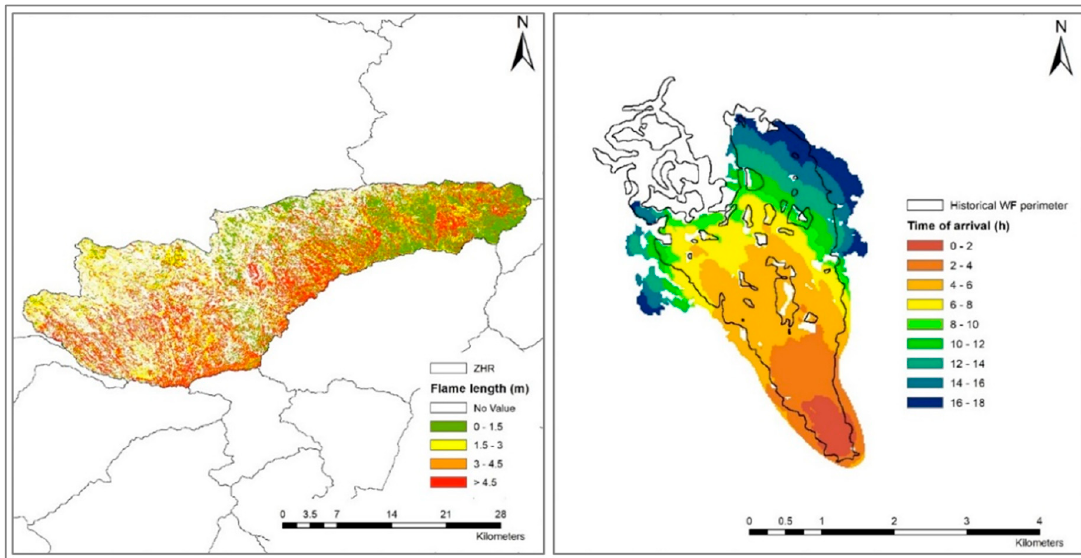
Figure 8. Examples of fire behavior outputs from fire simulation tools (left: flame length obtained from FlamMap; right: reconstruction of an historical fire and time of arrival using FARSITE) in two different areas of Catalonia using the PREVINCAT.cat database.